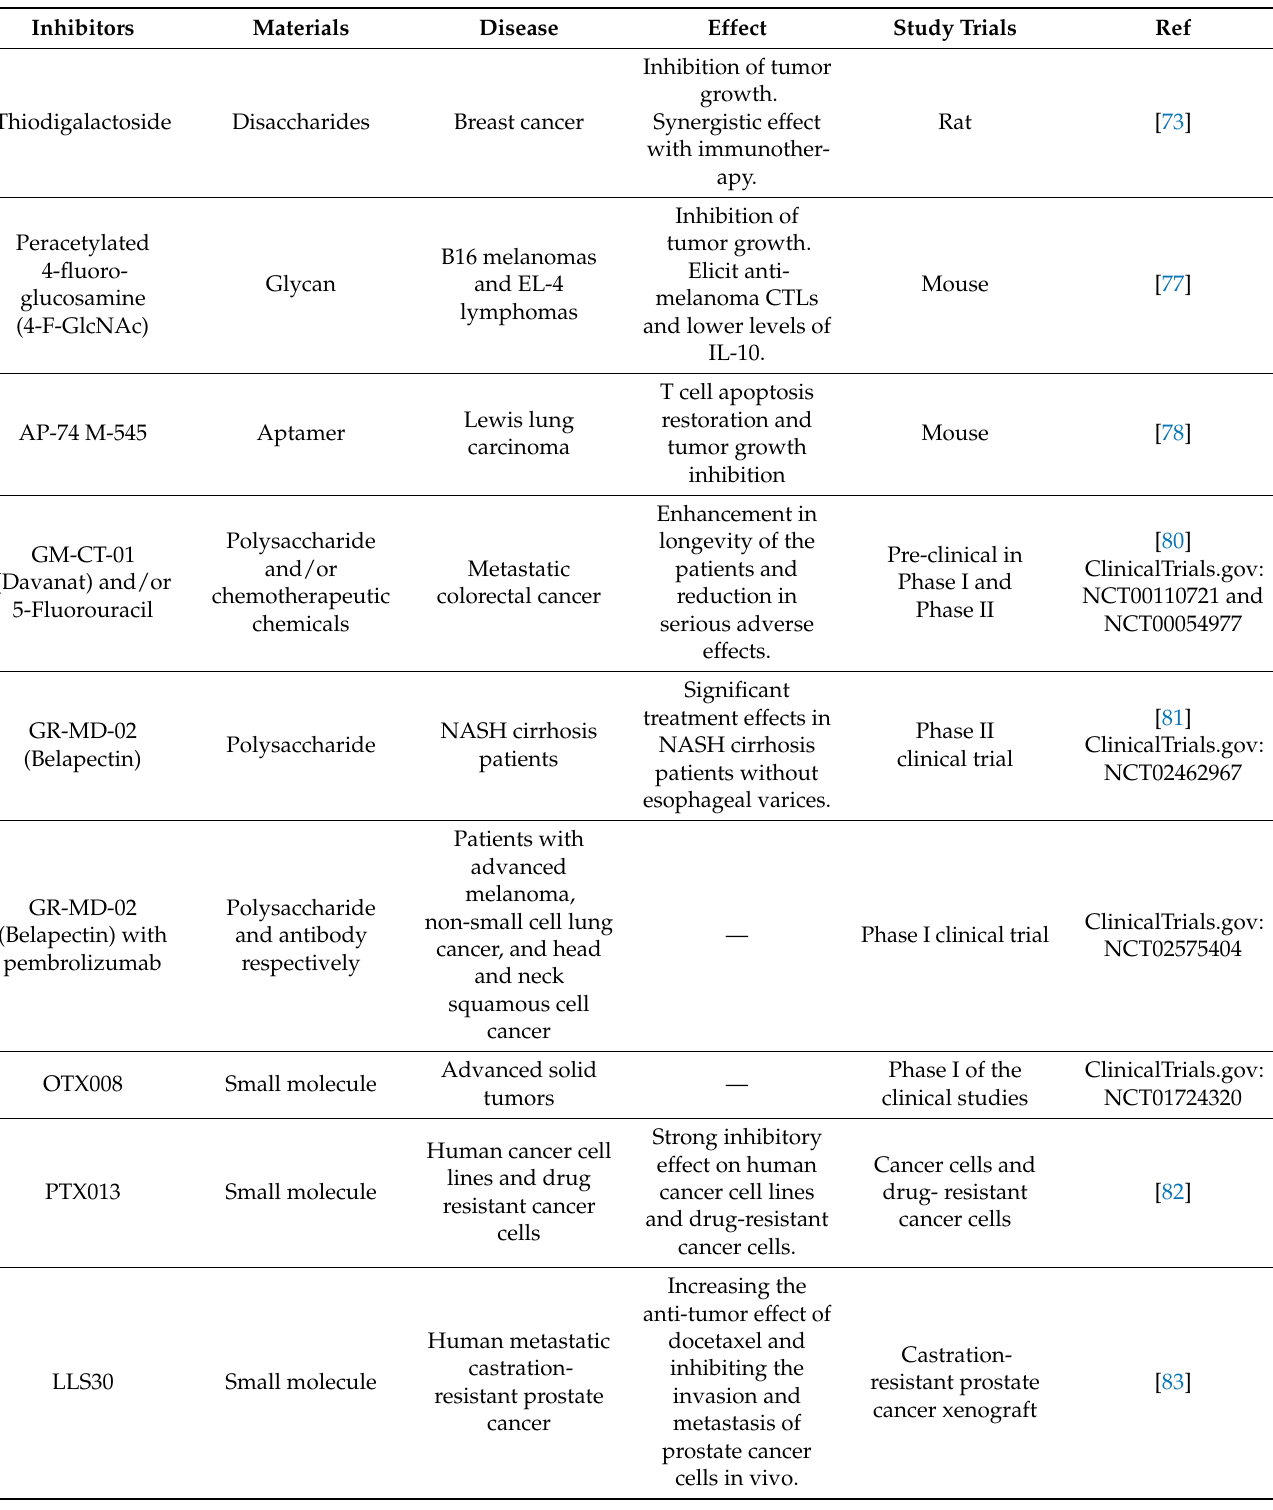
Table 1. Applications of Gal-1 inhibitors in anticancer